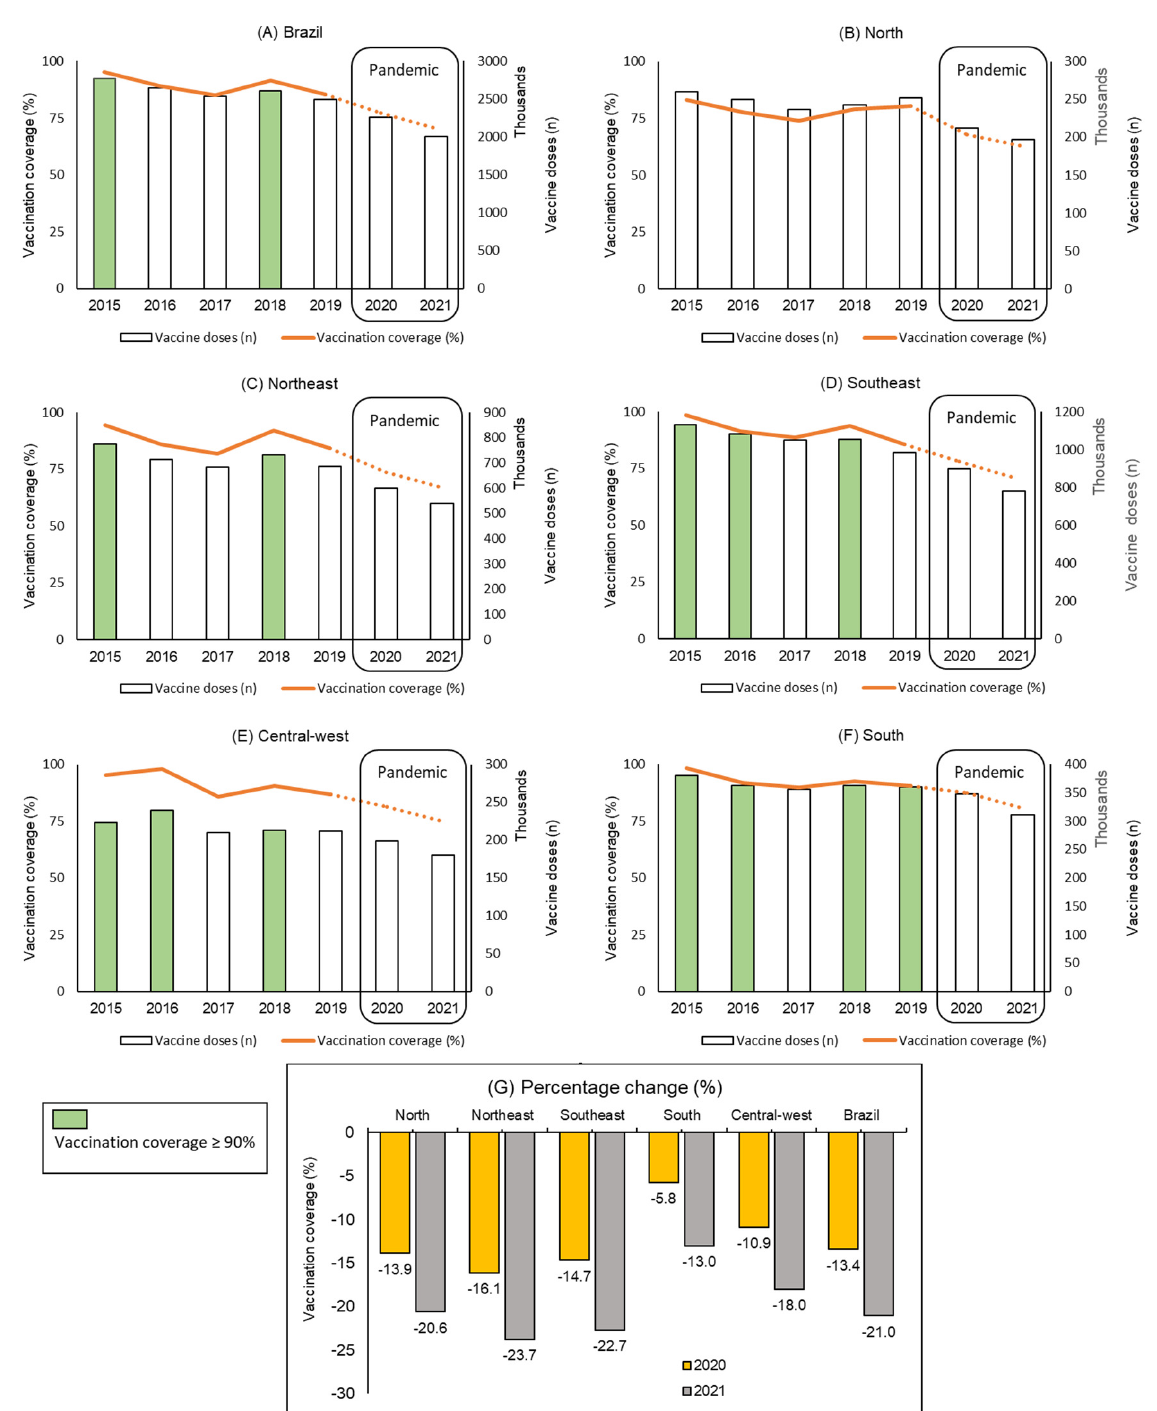
Figure 2. Temporal evolution of human rotavirus vaccination coverage before and during the COVID-19 pandemic in Brazil, according to regions. Brazil, 2015–2021. Figures ( A – F ) present the number of second doses applied (columns) in each region of the country and the proportional vaccination coverage achieved (row). The columns in green represent the years in which the regions reached the coverage target recommended by the Ministry of Health ( ≥ 90%). Figure ( G ) presents the impact of the COVID pandemic on vaccination coverage in the years 2020 and